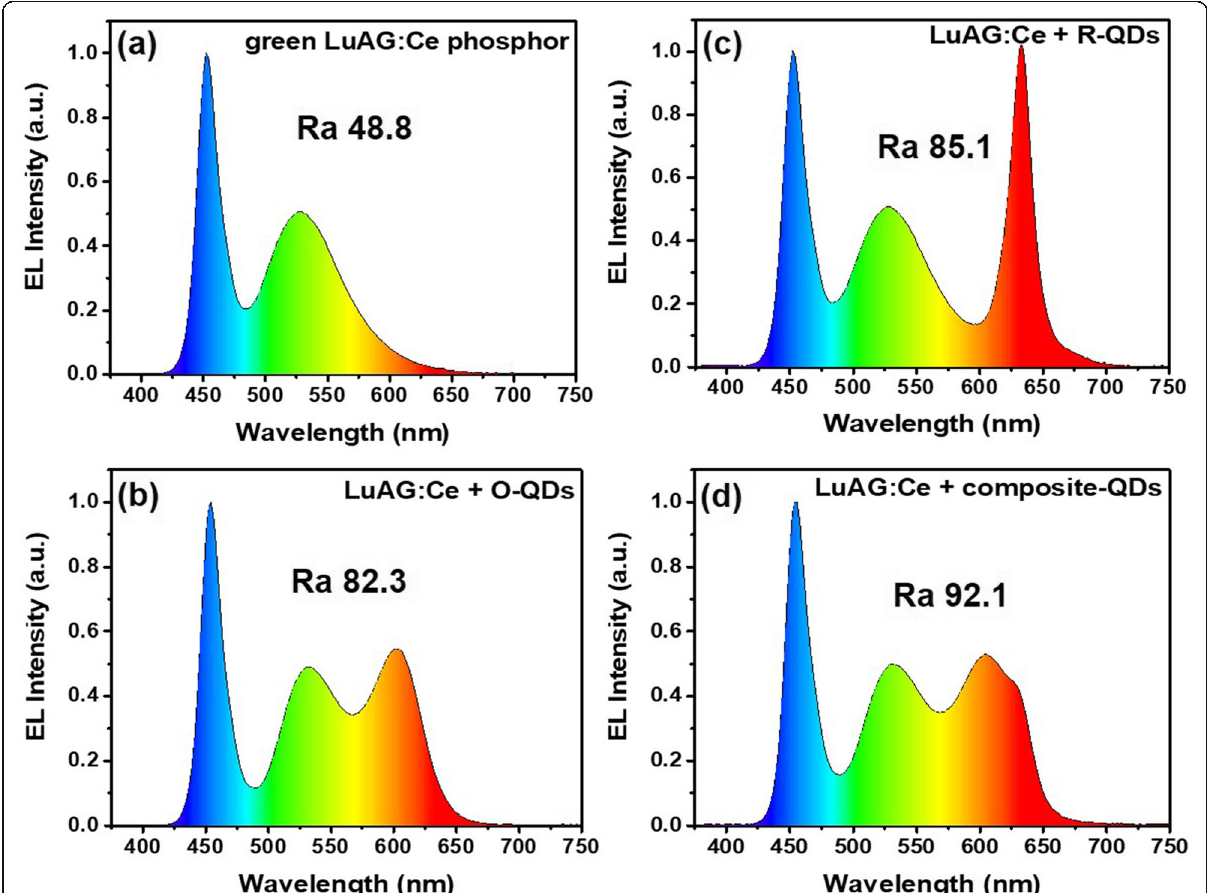
Fig. 7 EL spectra of WLEDs packaged with green LuAG:Ce phosphor only ( a ), LuAG:Ce+R-QDs ( b ), LuAG:Ce+O-QDs ( c ), and LuAG:Ce + composite-QDs